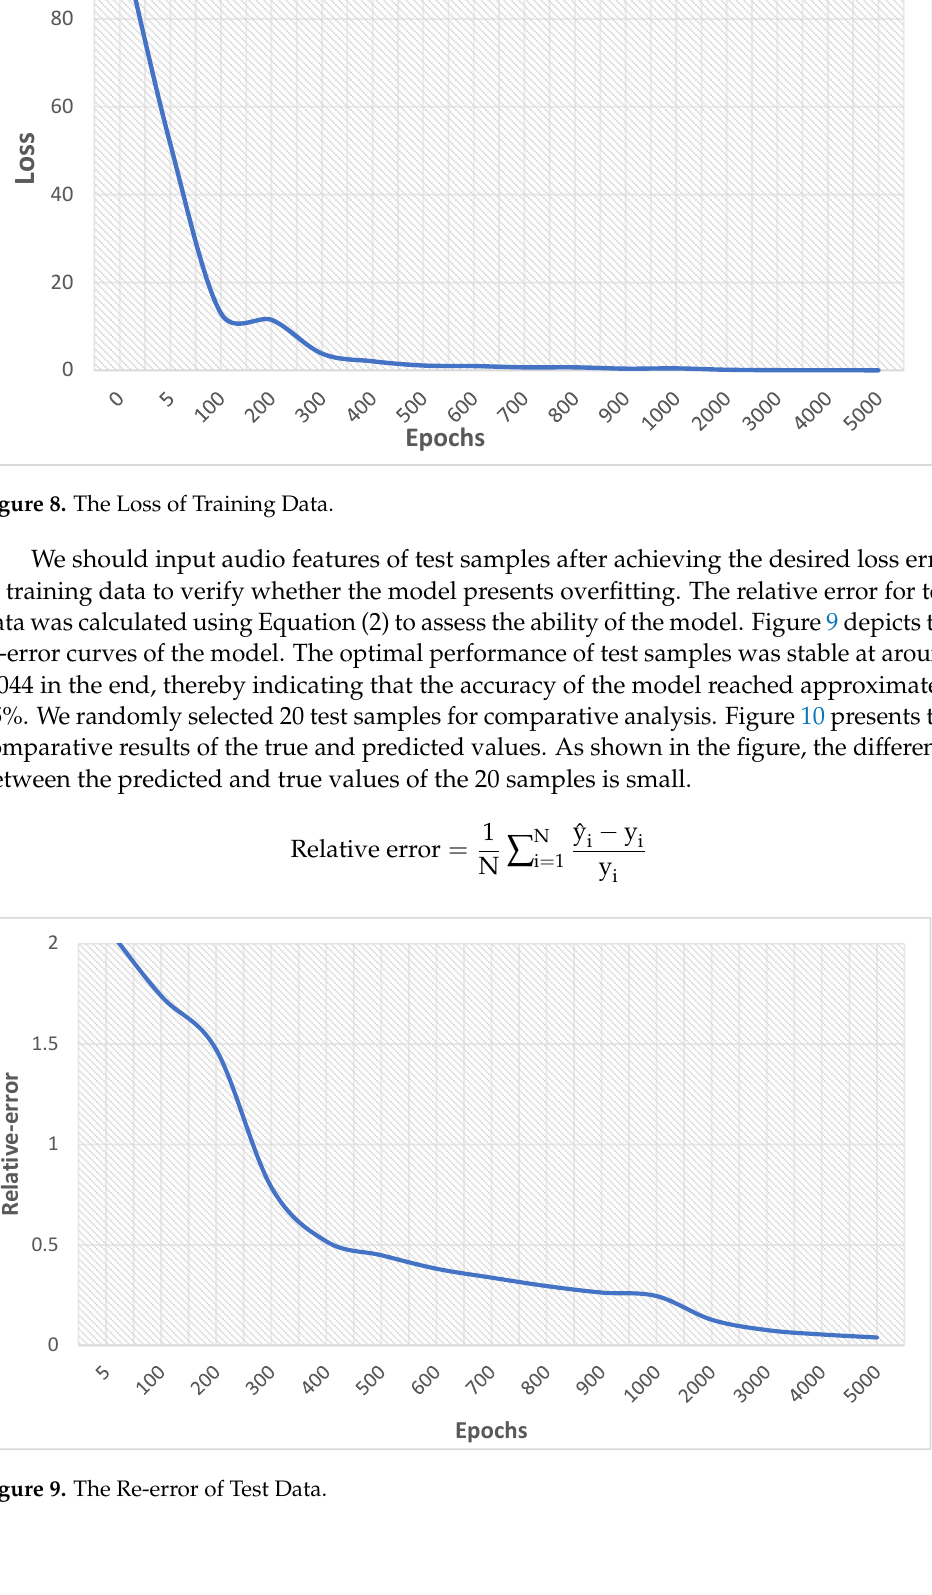
. Figure 10. Comparative Analysis of Twenty Test Samples. The results of speech stress recognition indicated that speech features (i.e., MFCC) can be used as effective indicators to distinguish various stress states during the stimu- lated nuclear power plant mission. 4. Discussion The present study aimed to develop a monitoring system that can conveniently and effectively assess the stress level of nuclear power plant operators in real time to avoid potential human error. Therefore, the speech-based stress recognition approach was adopted in this study instead of traditional subjective scales and physiological parame- ters. We first investigated whether the economical and easily applicable simulated nuclear power plant task is an effective tool for inducing high subjective stress levels without fo- cusing on social-evaluative components. Heart activity is correlated with stress[22], and skin conductance increases when the individual is under stress [23] due to the increase of moisture on the skin surface that increases the flow of electricity. The significant increase of both physiological indicators of heart rate and skin conductance in the present study